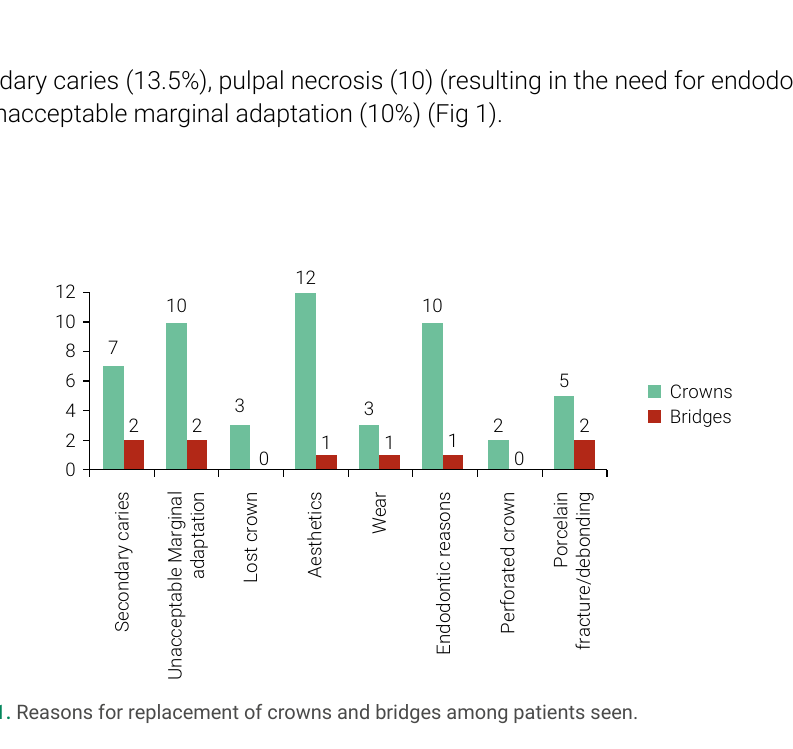
Aesthetic reasons